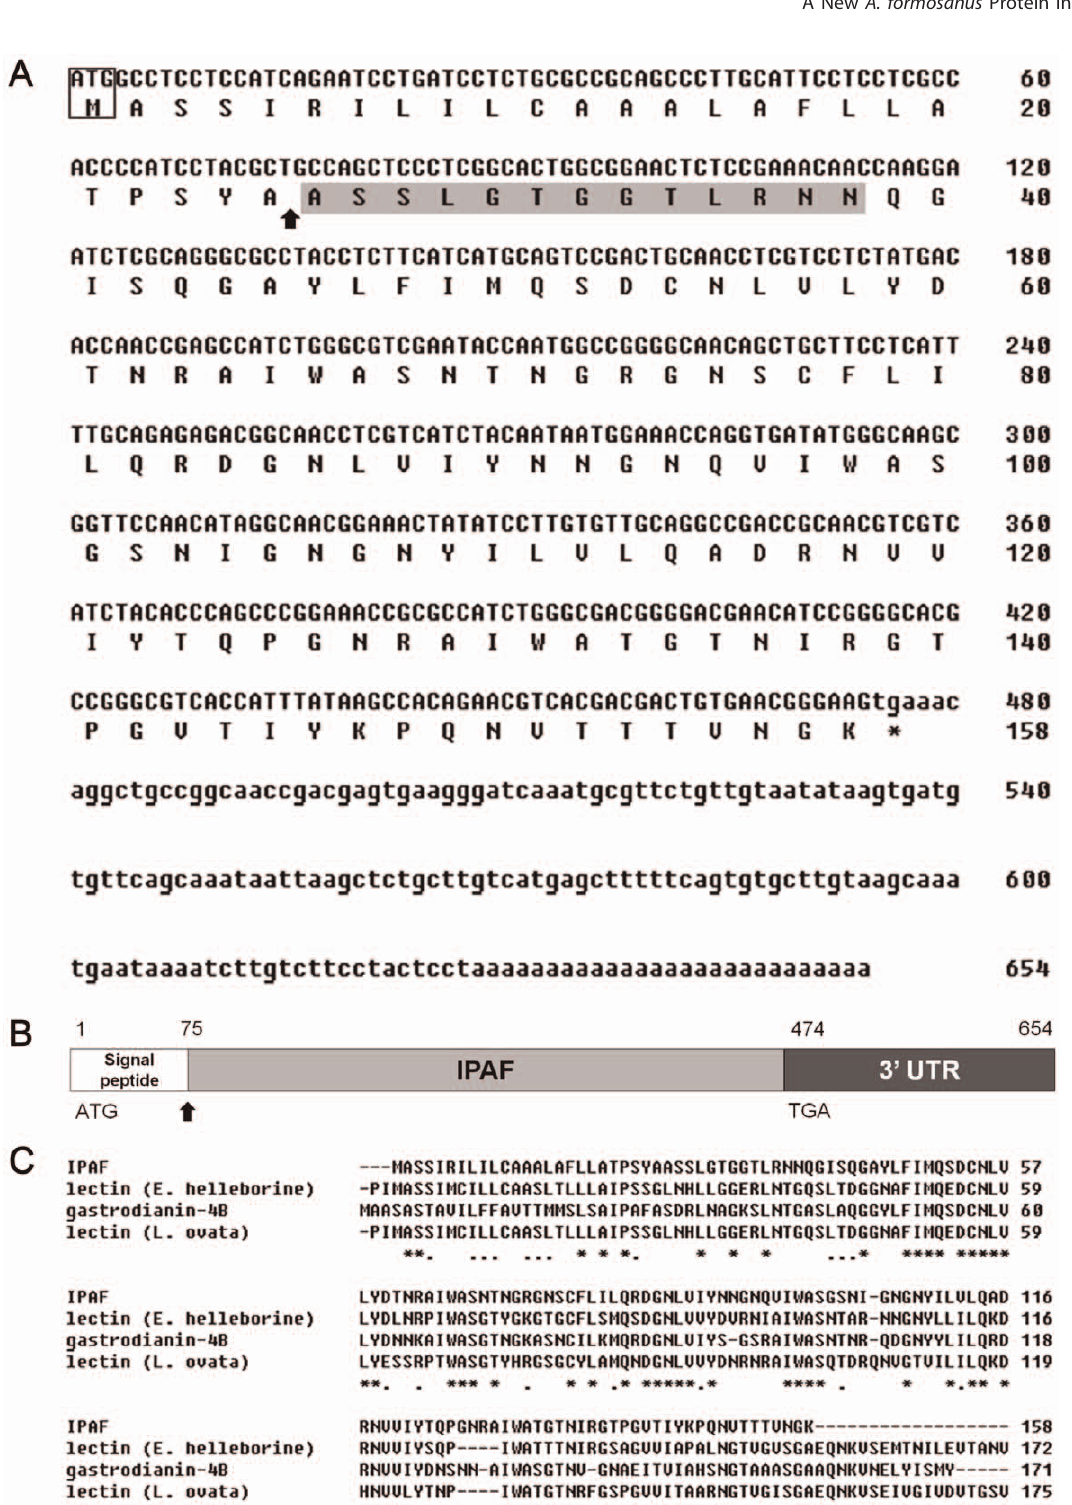
Figure 2. Molecular cloning of IPAF. (A) Complete nucleotide sequence of IPAF cDNA was derived by RACE PCR using specific primers of IPAF. The ORF ofIPAFcDNAispresentedincapitalletters,theterminationcodonismarkedwithanasterisk,andthe3 9 -UTRisdisplayedinlowercaseletters.Intheaminoacid sequence, the putative signal peptide cleavage site between Ala25 and Ala26, as predicted by SignalP, is showed with a vertical arrow, and the N-terminal amino acid sequence is indicated with a grey background. (B) Genomic structure of IPAF gene. The numbers represent base pair positions in the genomic sequence. The putative signal peptide, IPAF gene, and 3 9 -UTR are presented with white, grey, and dark-grey background, respectively. The vertical arrow indicates the corresponding cleavage site of the signal peptide. (C) Multiple alignment of IPAF amino acid sequence with sequences of lectins from Orchidaceae plants was performed by ClustalW2 program on the website of EMBL-EBI. The identical and the similar residues are marked with asterisks and dots, respectively.